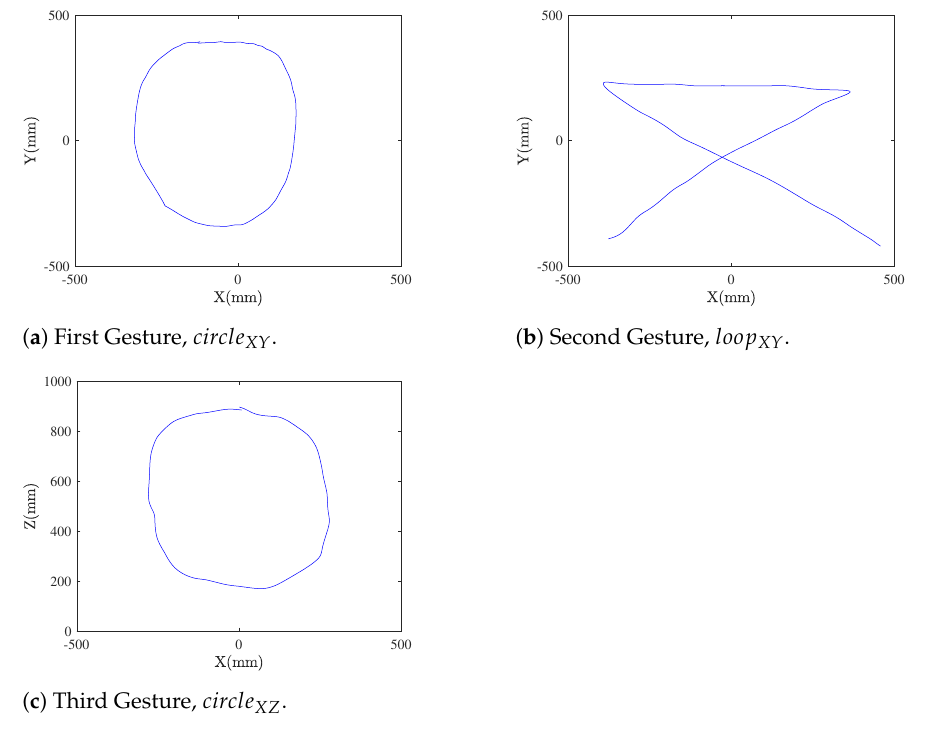
Figure 7. Gestures used in the